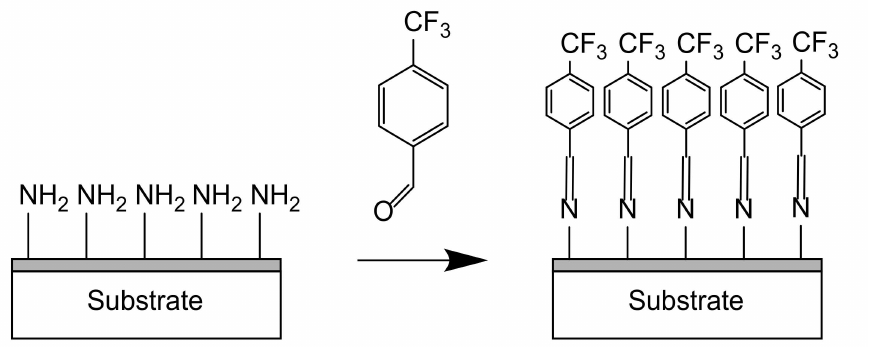
Figure 8. TFBA derivatization of primary amines. TFBA molecules are chemically grafted to the primary amines which are present in the coating. Then, fluorine can be quantified by XPS which allows the quantification of primary